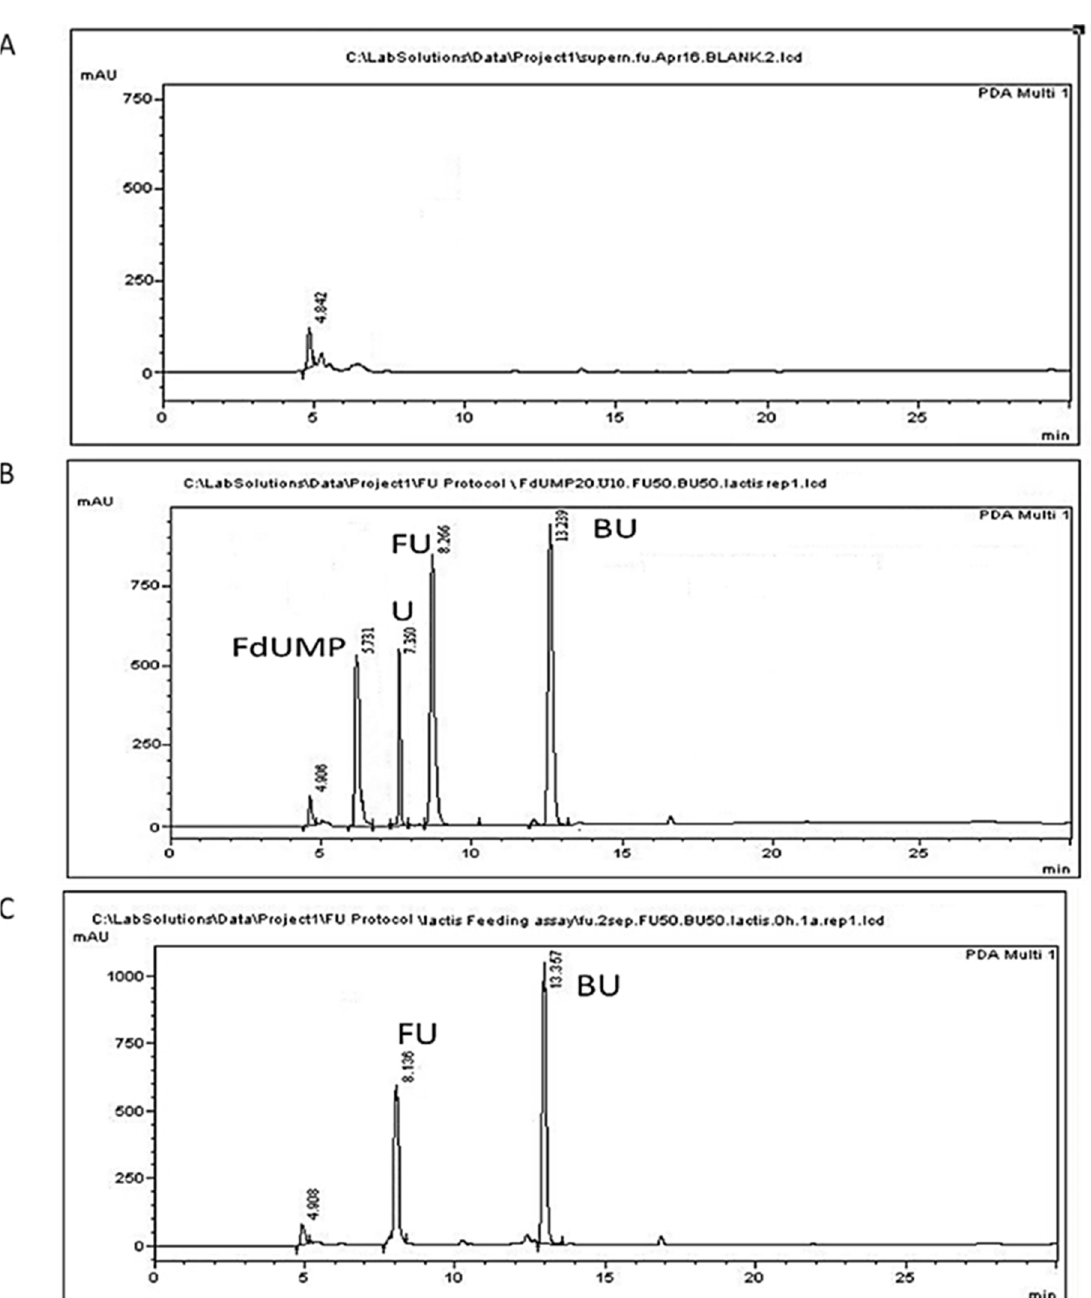
Figure 3. Representative chromatograms of L. lactis cell-free culture supernatants. ( A ) A blank sam- ple; ( B ) a BSM sample spiked with 50 μ g/mL of 5-FU (FU), 10 μ g/mL uracil (U), 30 μ g/mL FdUMP (FdUMP), and 50 μ g/mL of the internal standard 5-BU (BU); ( C ) culture supernatant collected at 0 h following administration of 50 μ g/mL 5-FU at 0 h.